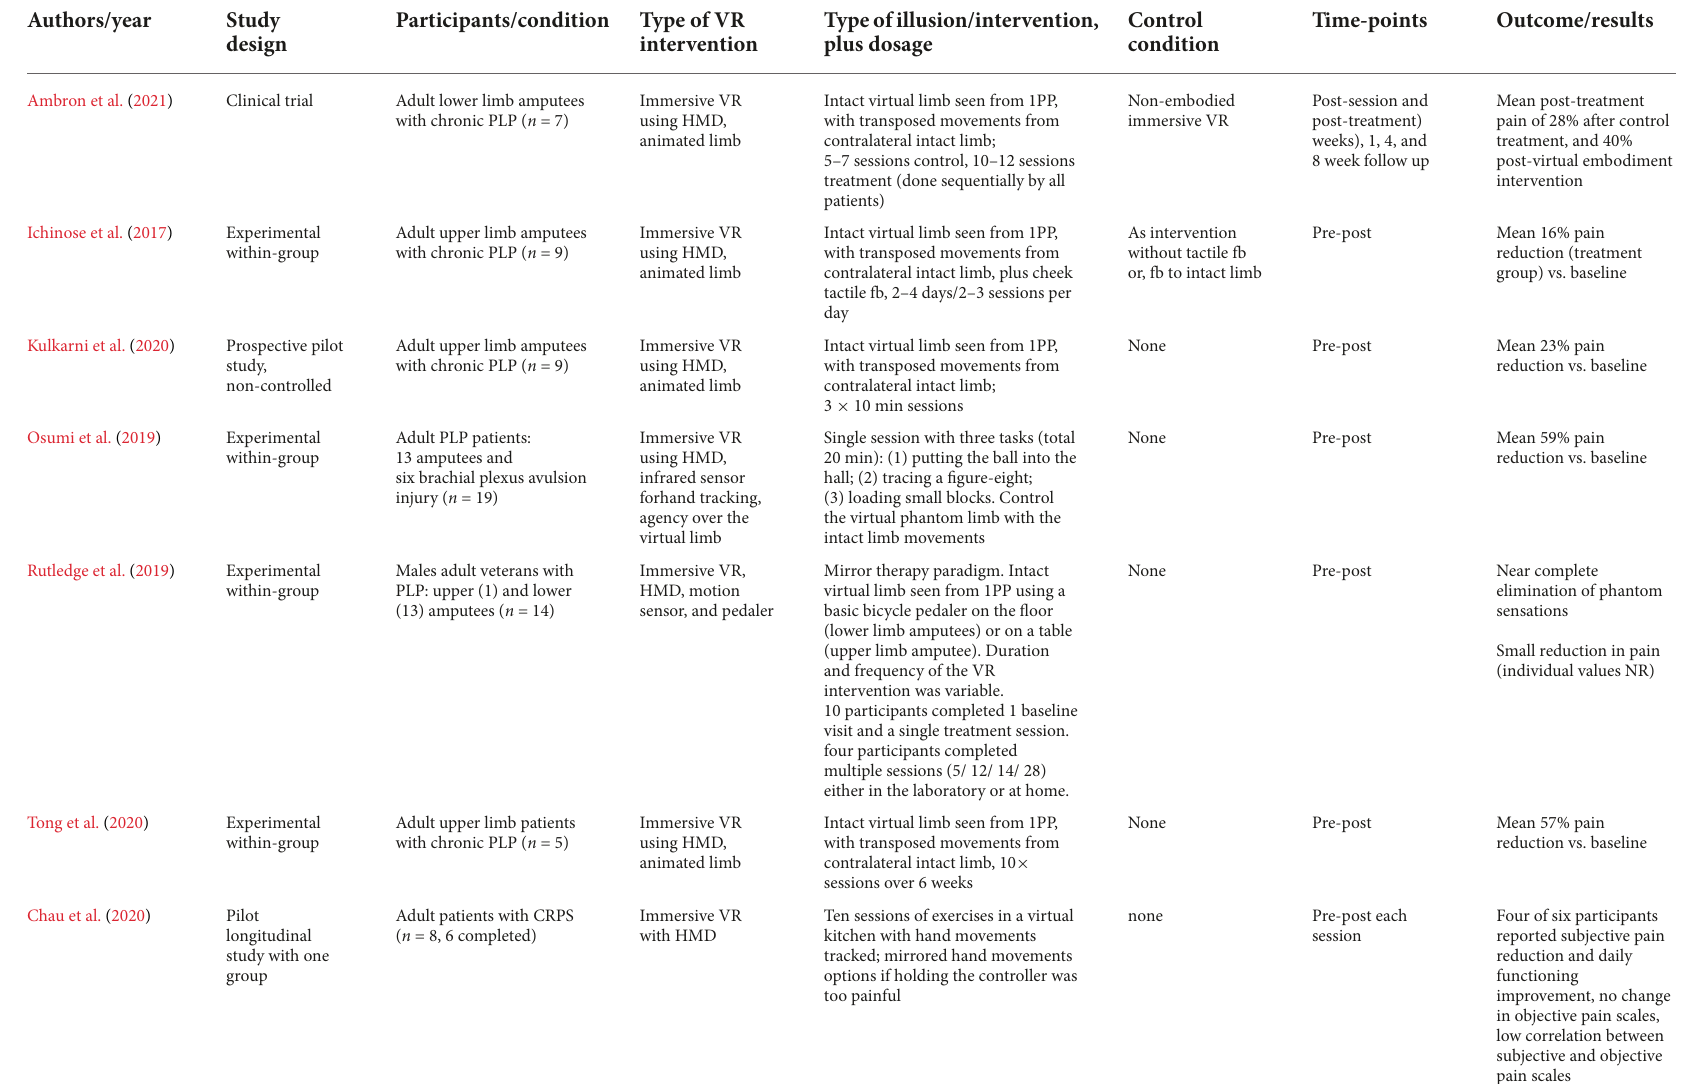
TABLE 1 Summary table of virtual reality studies for the treatment of peripheral neuropathic